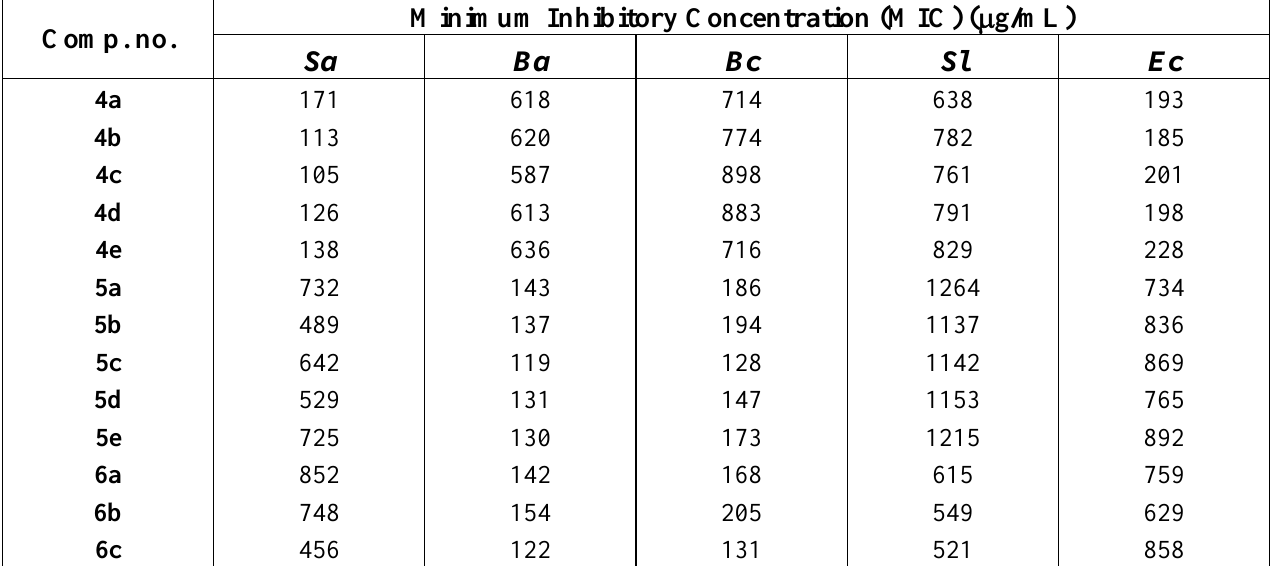
Table 1. Antimicrobial activity of compounds 4a-e , 5a-e and 6a-c .